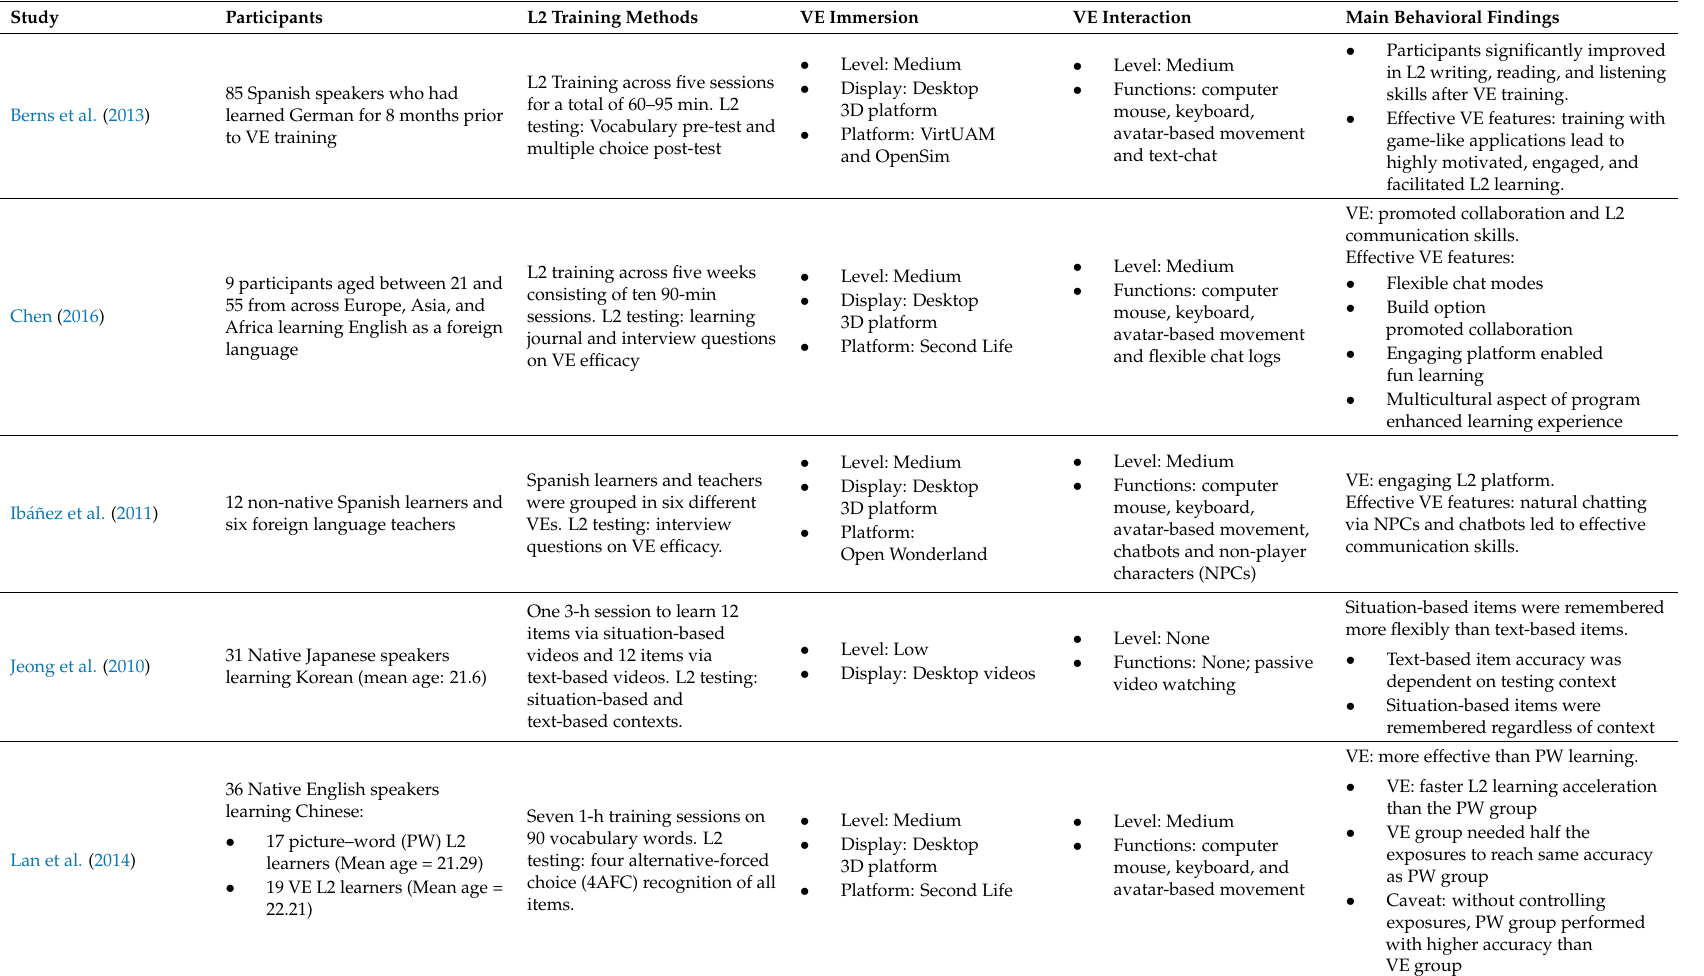
Table 1. Summary of studies examining the efficacy of virtual environment (VE) platforms for L2